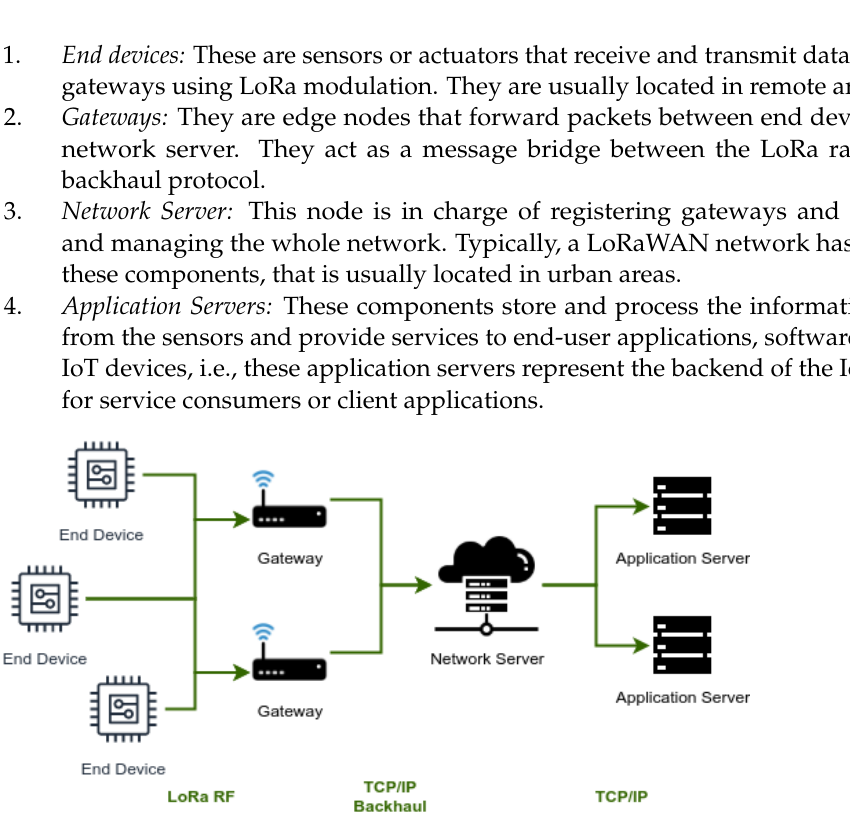
Figure 1. Diagram of a typical LoRaWAN network